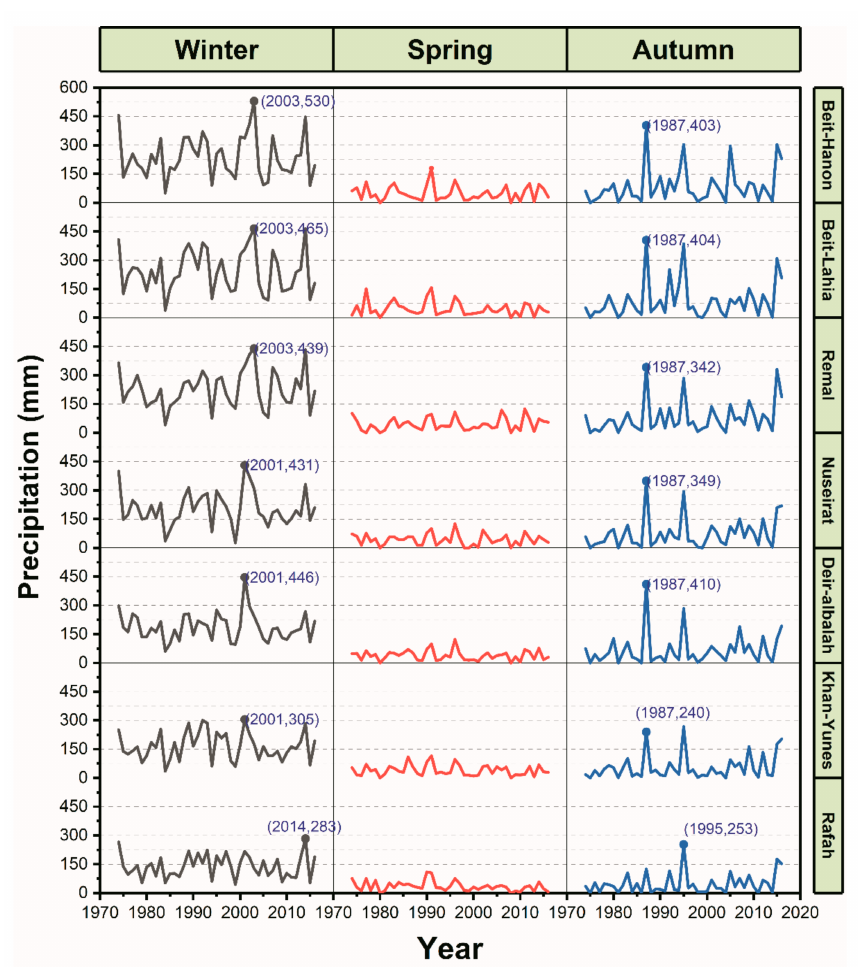
Figure 3. Seasonal precipitation at seven meteorological stations in Gaza during